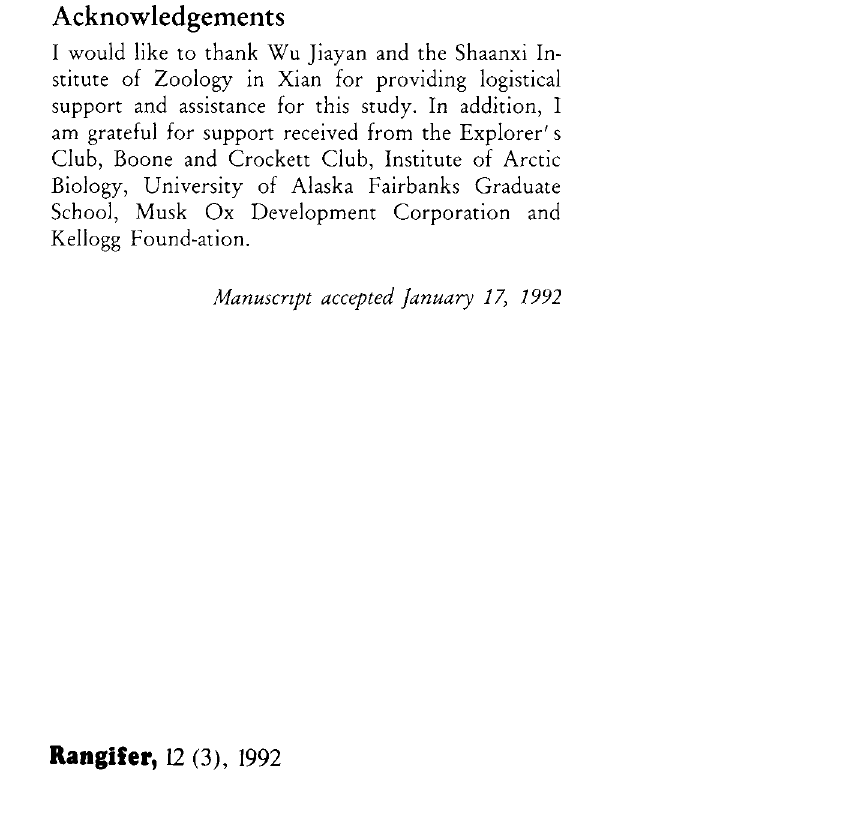
Fig. 3. Average vegetation density of transects by ha bitat and takin feeding. Average density of al pine transects with feeding significantly grea ter than all alpine transects and alpine no fee ding transects (p <